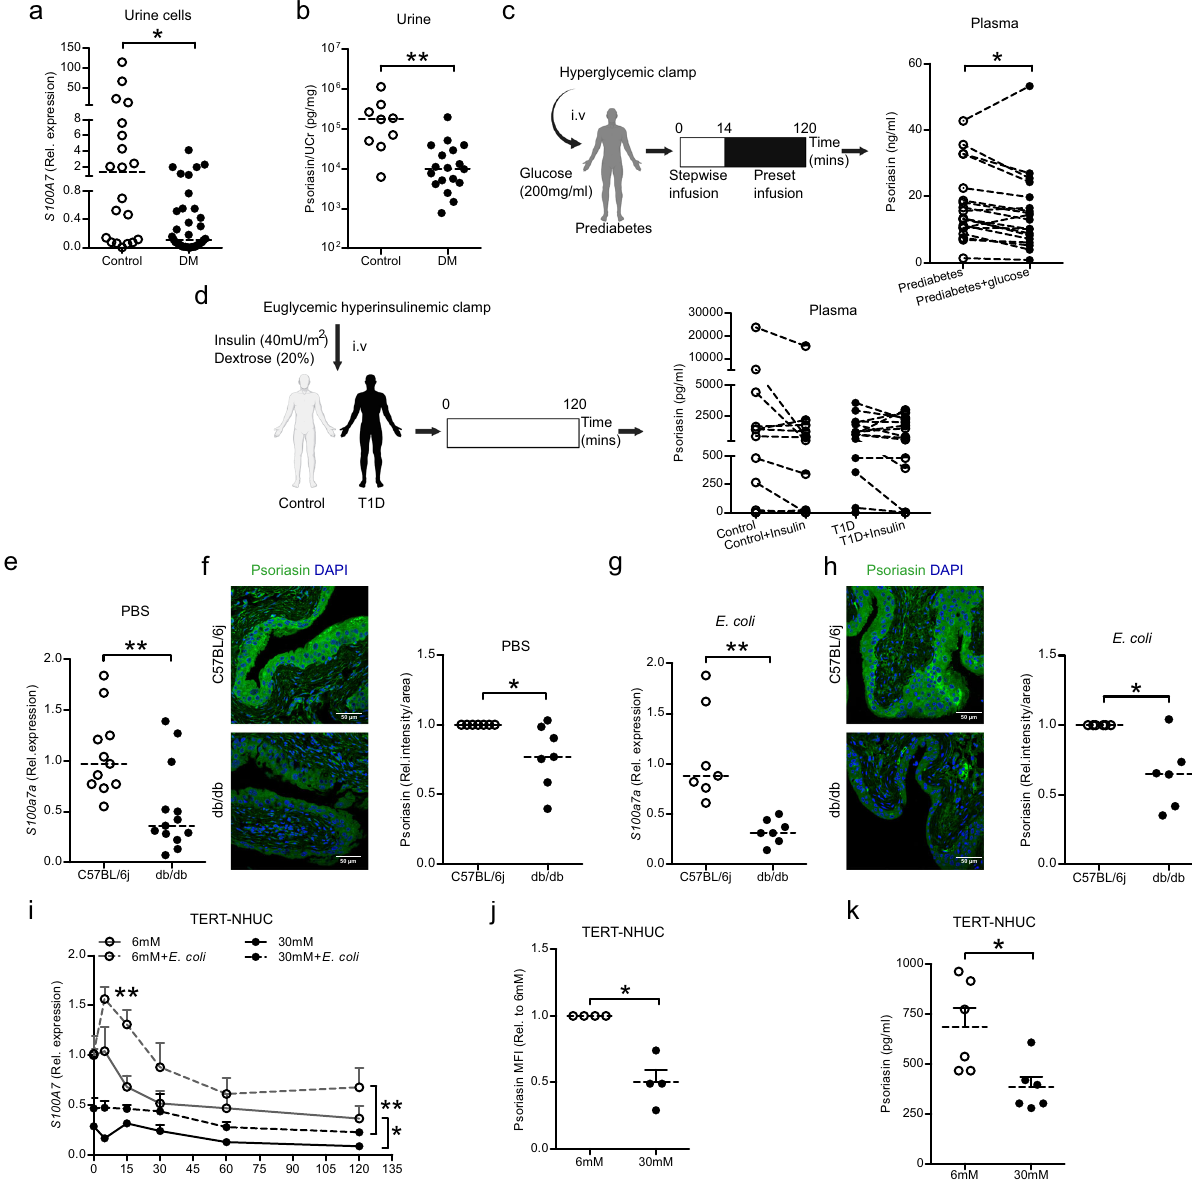
Fig. 1 | High glucose downregulates expression of psoriasin in plasma and urinary bladder. a Expression of S100A7 mRNA in urine cells of patients with diabetes (DM), ( n =36) and non-diabetic individuals ( n =20) (unpaired two-tailed t test, p =0.0164). b Urine psoriasin normalized to urine creatinine (Ucr), in DM ( n =18)andnon-diabeticindividuals( n =9)(unpairedtwo-tailedttest, p =0.0094). c Schematicpresentation of hyperglycemic clamps in prediabetes ( n =19), plasma psoriasinanalysisbeforeand2hafteri.v.glucoseinfusion(pairedtwo-tailedttest, p =0.0264). d Schematic presentation of euglycemic, 5mM, hyperinsulinemic clamp in type 1 diabetes (T1D) ( n =23) and healthy ( n =18) individuals, plasma psoriasin analysis before and after insulin treatment (paired two-tailed t test). Expression of e S100a7a mRNA (unpaired two-tailed t test, p =0.0044) and f protein in PBS treated diabetic, db/db ( n =13; n =7) and non-diabetic, C57BL/6j ( n =11; n =7) mice respectively (Mann-Whitney two-tailed test, p =0.0204). Expression of g S100a7a mRNA (unpaired two-tailed t test, p =0.0017) and h protein in 24h E. coli infected, db/db ( n =7; n =6) and C57BL/6j ( n =7; n =6) respectively (Mann-Whitney two-tailed test, p =0.0493). i S100A7 mRNA 5 ( n =6